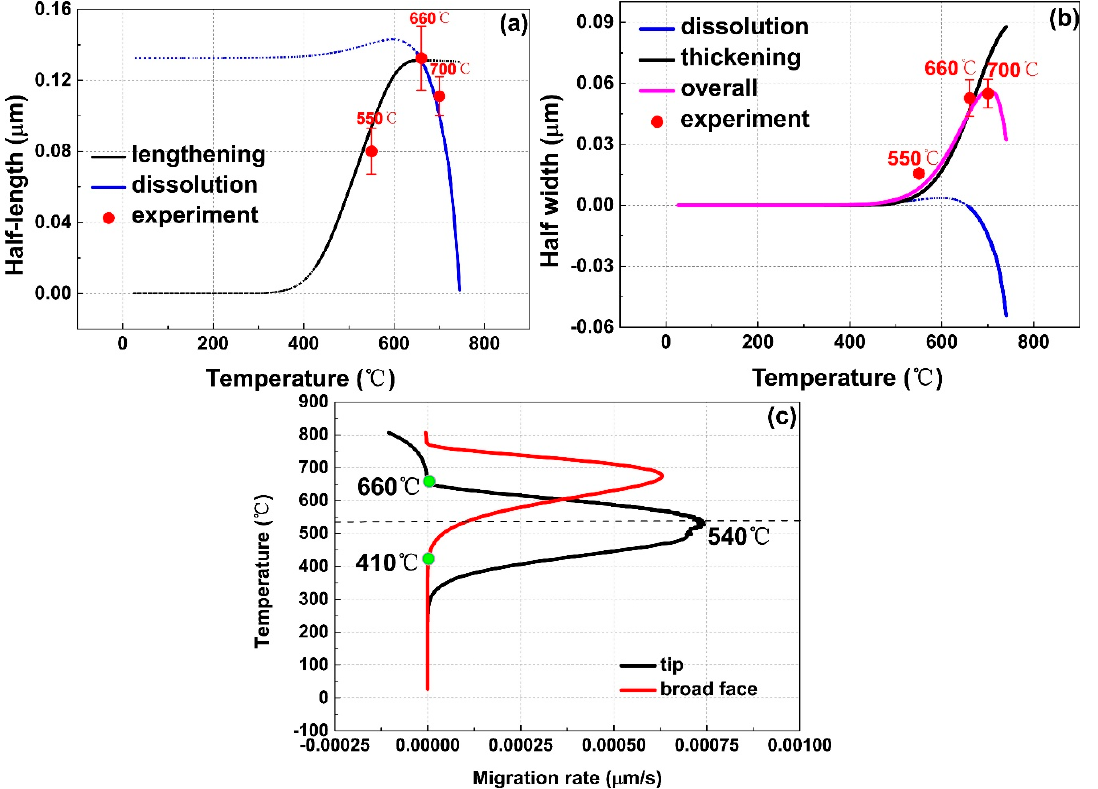
Figure 5. ( a ) Calculated growth (black) and dissolution (blue) curves for α lamellar tip; ( b ) thickening (black), dissolution (blue), and real interface migration (magenta) curves for α lamellar broad face are compared with the measured average length and width of α lamellae at different temperatures (red disc). ( c ) The calculated migration rates of tip and broad face in lamellar α phase.